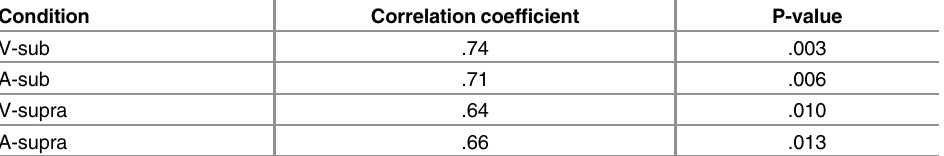
.66 .013 Note. V and A stand for the visual and auditory modalities, respectively. Sub and supra represent the sub- second and supra-second intervals, respectively. P-values were Bonferroni-corrected for four